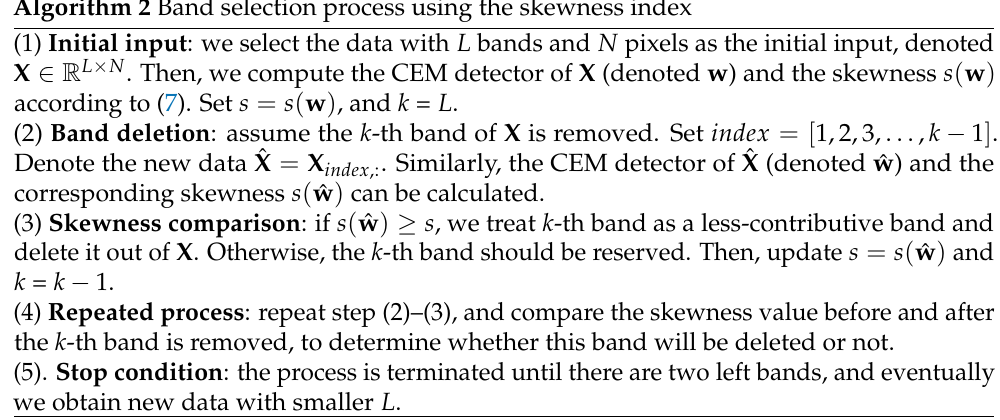
Algorithm 2 Band selection process using the skewness index